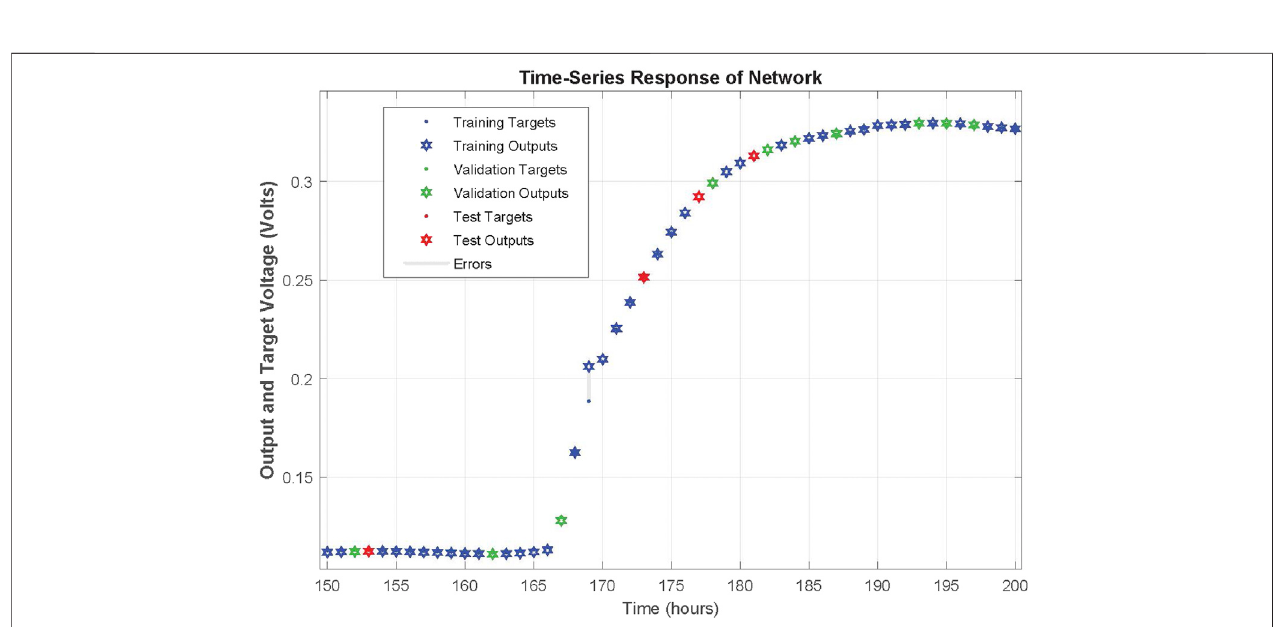
FIGURE 6 | Zoomed in response of NARX on training, validation and testing dataset time-series of fi rst MFC at the fi rst re fi lling of